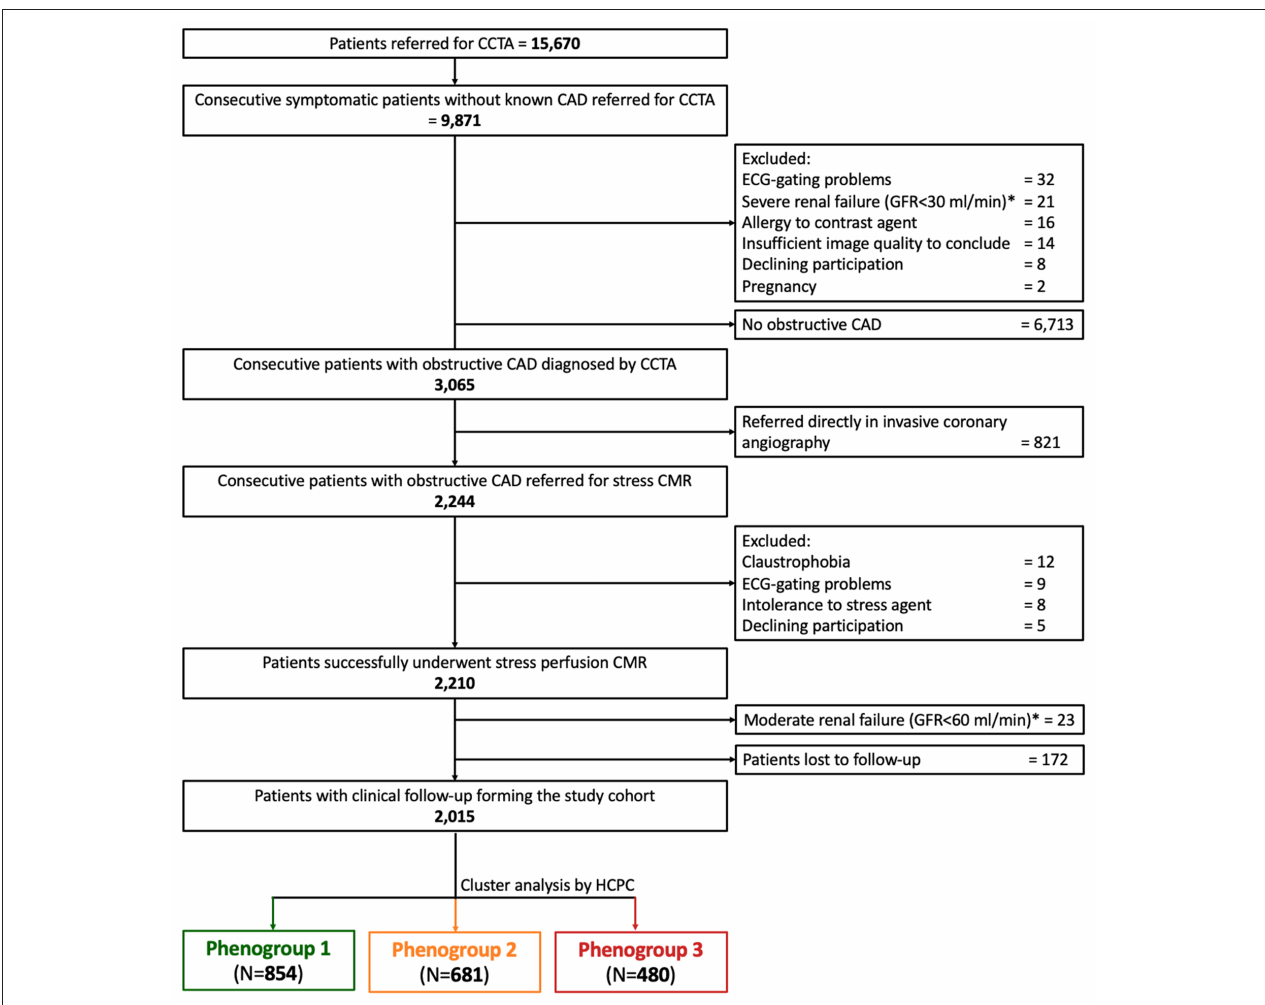
FIGURE 1 | Flowchart of the study. CAD, coronary artery disease; CCTA, coronary computed tomography angiography; CMR, cardiac magnetic resonance; GFR, glomerular filtration rate; HCPC, hierarchical clustering on principal components.